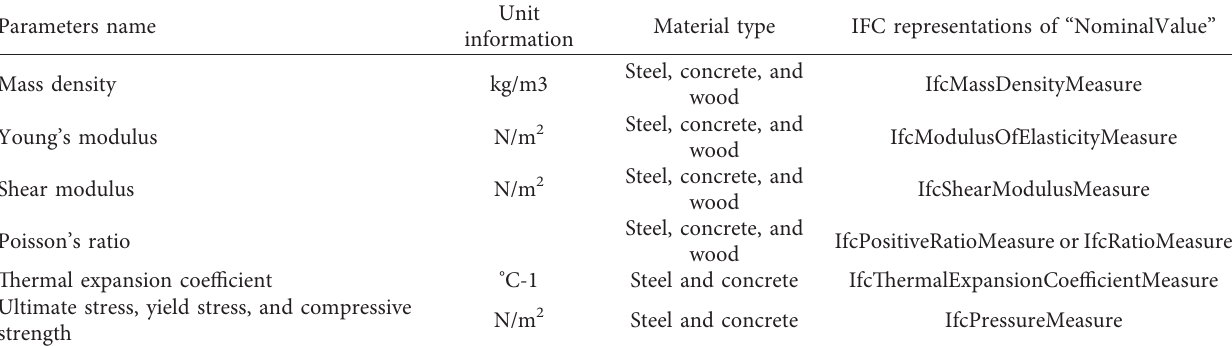
Table 3: IFC-based invariant material signatures representation implementations.